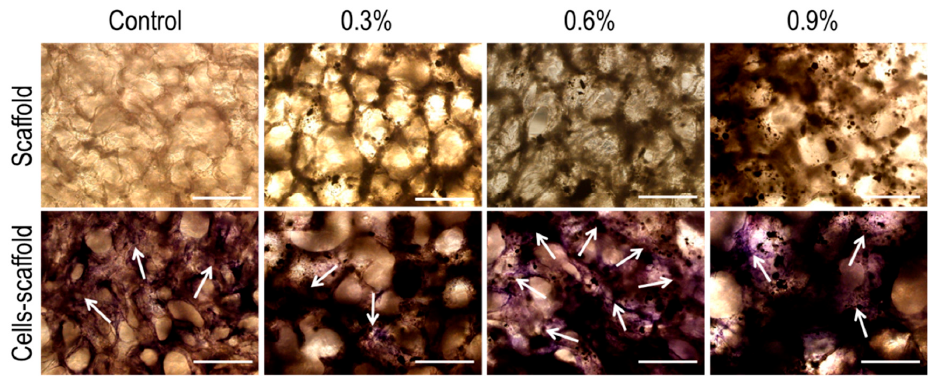
Figure 10. ALP staining of MC3T3-E1 cells on CS/Gel/nHAp/MWCNTs scaffolds. ALP staining (blue-purple) showing the content of ALP that MC3T3-E1 secreted in the process of in vitro culture and differentiation, indicating osteogenic differentiation and mineralization ability of the MC3T3-E1 cells on the scaffolds; the white arrows mark the spread of ALP. Scale: 250 μ m.